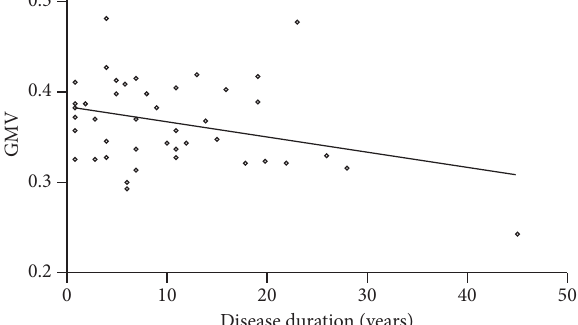
Figure 3: The decreased gray matter volume of the middle frontal cortex in MwoA was negatively correlated with patients’ disease duration ( p � 0 .